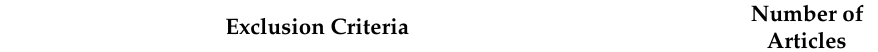
Other elements than CTCs: in liquid biopsy, non-circulating,